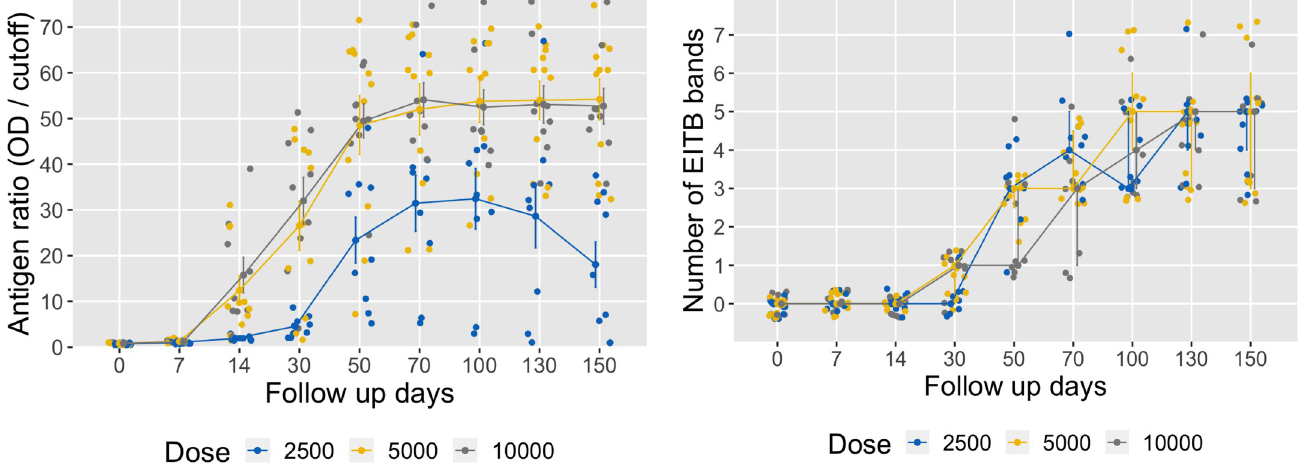
Fig 4. Dynamics of antigen and antibody response profiles at follow up days according to oncosphere-dose groups. (A) Antigen levels summarized using means ± standard errors; (B) Numbers of EITB bands summarized using medians with IQR (interquartile ranges).